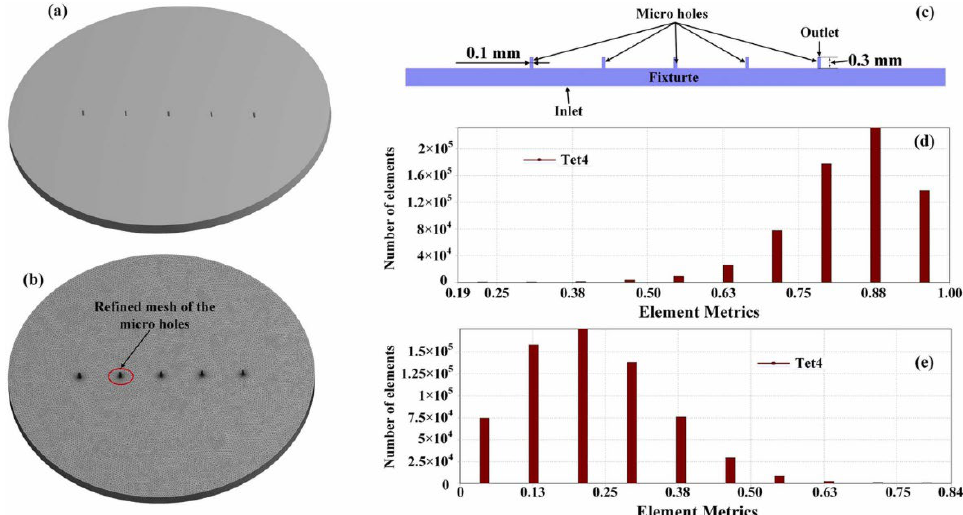
Figure 17. ( a ) The three-dimensional view of the media’s flow channels; ( b ) the mesh distribution, and ( c ) the 2D cross-section of micro porous structures, as well as the mesh metrics of ( d ) element quality and ( e ) skewness [132].